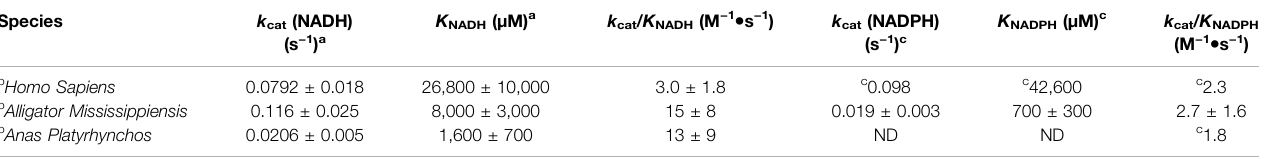
TABLE 3 | Steady-state kinetic parameters for NQO2s with NADH and NADPH.